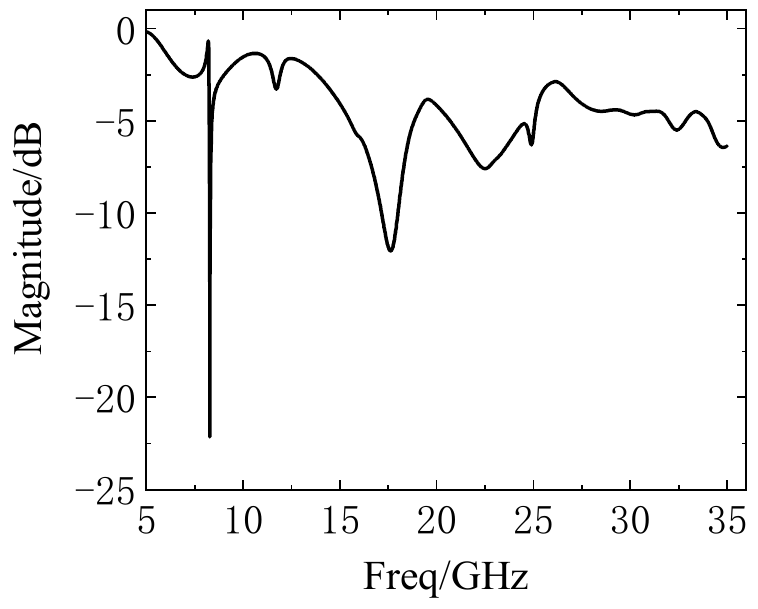
Figure 6. Spectrum curve of a single U-shaped slot resonator. Considering that this structure generates second harmonics at 17.67 GHz, the fun- damental frequency of the shortest U-shaped slot cannot exceed 17.67 GHz. Otherwise, the second harmonic of the longest slot interferes with the encoded data onto the shortest slot and eventually causes bit errors. Therefore, the available coding frequency band is 8.28 GHz to 17.67 GHz. The bandwidth occupied by a single resonator is 40 MHz. If the guard band of the spectrum-characteristic notches of adjacent resonators is 260 MHz, the 31-bit frequency position code can be formed in the available frequency band, and the largest code states can reach 2 31